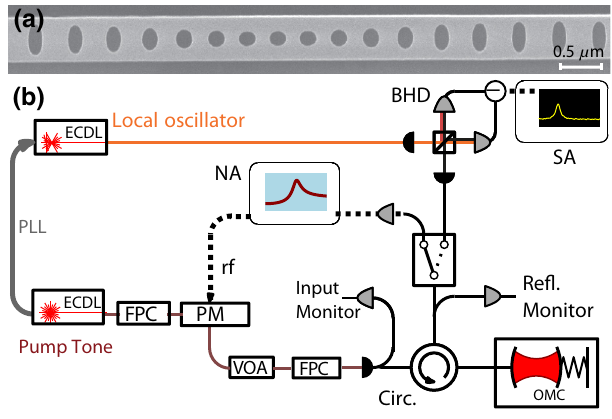
FIG. 5. Experimental setup for optomechanical spectroscopy. (a) SEM image of the silicon optomechanical crystal cavity. (b) Detailed experimental setup. ECDL, external-cavity diode lasers; FPC, fiber polarization controller; PM, phase modula- tor; VOA, variable optical attenuator; BHD, balanced heterodyne detector; SA, spectrum analyzer; NA, network analyzer; PLL, phase-locked loop.